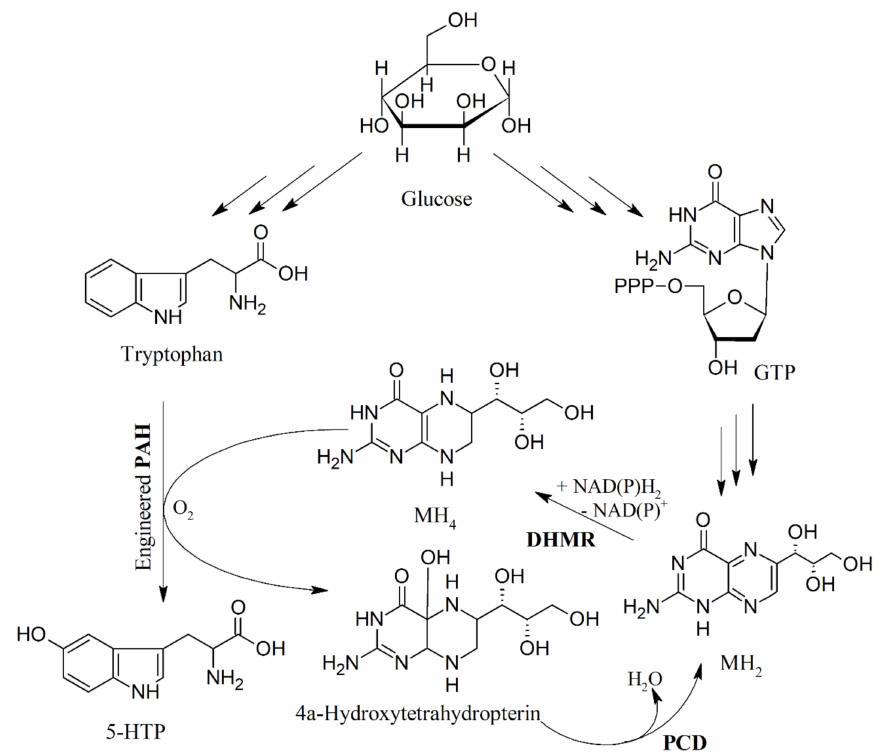
Figure 7. Production of 5-HTP from tryptophan in E. coli by engineered PAH and the utilization of tetrahydromonapterin (MH 4 ) instead of BH 4 . DHMR, dihydromonapterin reductase; PAH, phenylala- nine 4-hydroxylase; PCD, pterin-4 α -carbinolamine dehydratase; MH 2 , dihydromonapterin. Modified from [88].